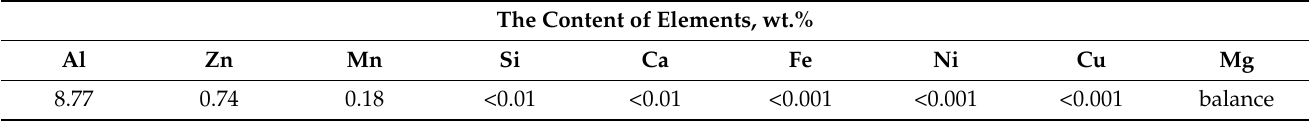
Table 1. Chemical composition of the AZ91D alloy. The Content of Elements,